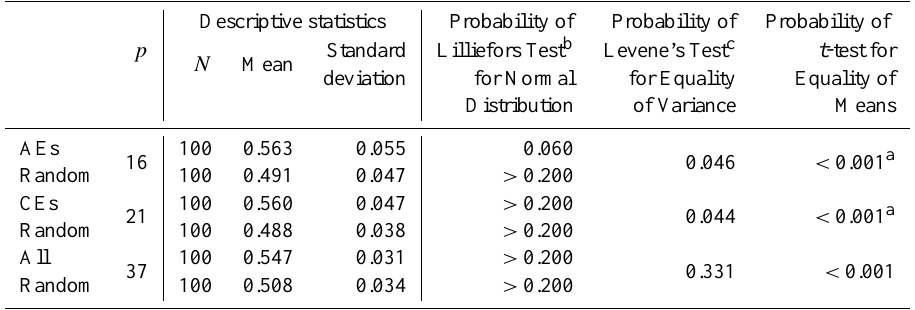
Table 1. T -test analysis.